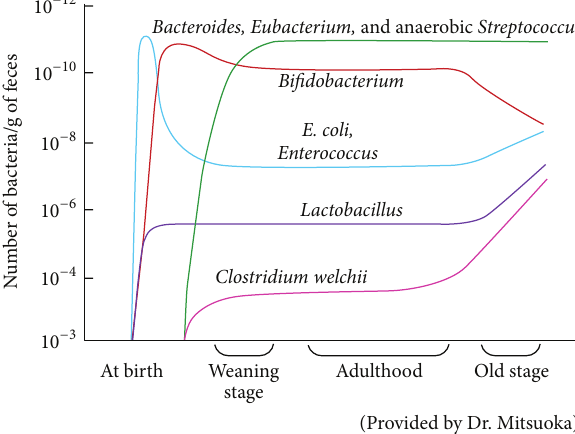
Figure 3: Age associated changes of intestinal flora